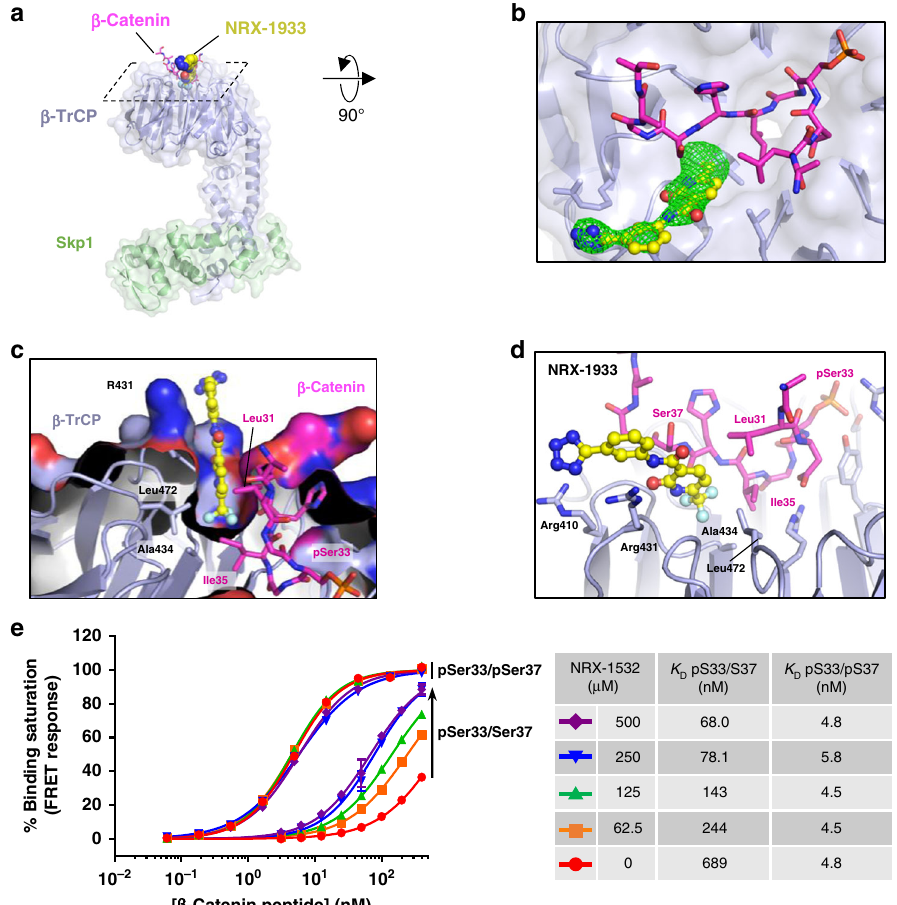
Fig. 2 NRX-1933 binds at the pSer33/Ser37 β -catenin: β -TrCP interface and potentiates the binding af fi nity of the interaction. a Overall structure of NRX- 1933 (yellow spheres) bound to the β -catenin: β -TrCP complex (PDB: 6M93) (Supplementary Table 1). b Unbiased Fo-Fc electron density for NRX-1933 at 3.0 standard deviations above the mean is shown (green). The compound is shown as sticks (yellow), bound between the surface of the β -TrCP β -propeller (gray) and the monophosphorylated β -catenin degron peptide, shown as sticks (magenta). c Cutaway view of the hydrophobic pocket formed by residues Leu472 and Ala434 from β -TrCP and Ile35 and Leu31 from β -catenin. d Side view of the same interaction with the β -TrCP surface removed, highlighting the β -catenin and β -TrCP residues that interact with NRX-1933. e The binding af fi nities of the pSer33/Ser37 and pSer33/pSer37 β -catenin peptides for β -TrCP were measured in the TR-FRET assay by titrating BODIPY-FL-labeled β -catenin peptides (residues 17-48) against 300 pM β -TrCP at varying concentrations of NRX-1532. The binding curves for the pSer33/pSer37 β -catenin peptide titrations were fi tted to one-site binding model. For the pSer33/Ser37 β -catenin peptide titrations, which do not reach saturation owing to limitations in the maximum amount of fl uorophore compatible with this assay. Curves were fi tted to the same one-site binding model, with the upper plateau constrained to that of the pSer33/pSer37 β -catenin peptide binding curve. The K D s are reported for both pSer33/Ser37 and pSer33/pSer37 β -catenin